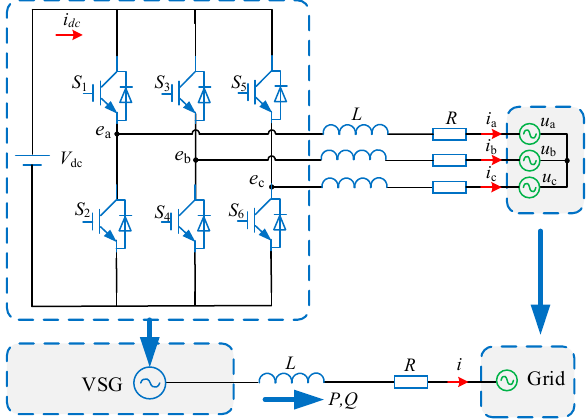
Figure 1. The three-phase converter and configuration of the virtual synchronous generator (VSG).